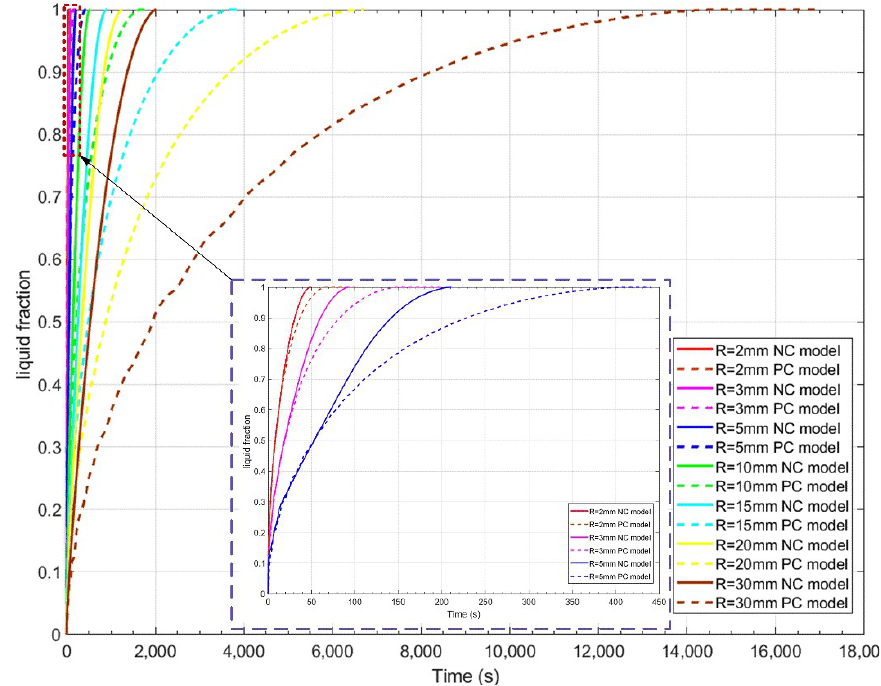
Figure 11. Comparison of liquid fraction calculated by the PC and NC models for the case of ∆𝑇 = 10 K . ∆ T = 10 K. Table 2. Total melting times for the NC and PC models with different sphere sizes and heating